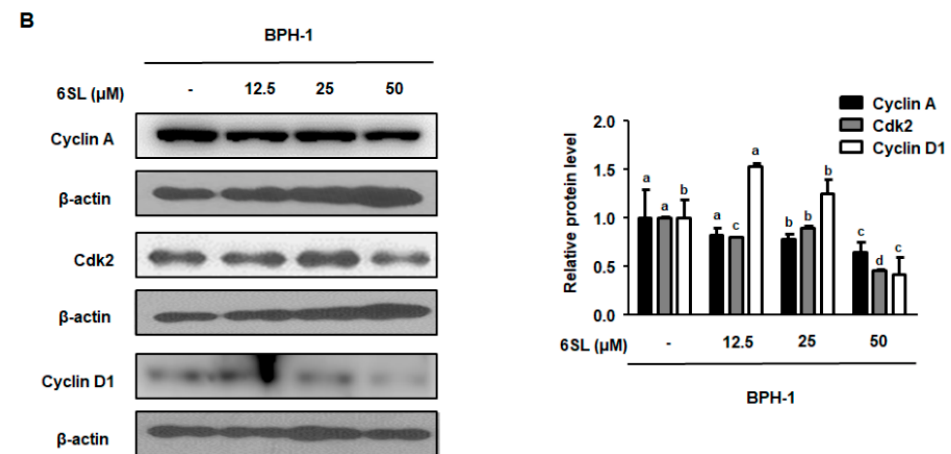
Figure 5. The depressant effect of 6SL on E2F1-dependent cell cycle protein expression in BPH-1 cells. ( A ) pRb, E2F1, and ( B ) Cyclin A, Cdk2, Cyclin D1 protein levels were analyzed by immunoblotting. The densities of proteins were calculated using ImageJ Software. Relative protein level was normalized to β -actin and values of three separate experiments are represented as mean ± SD. Different letters indicate significant differences, p < 0.05.